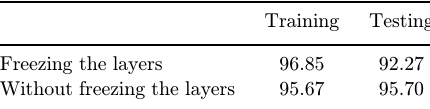
Table 2. Transfer learning models' accuracy.